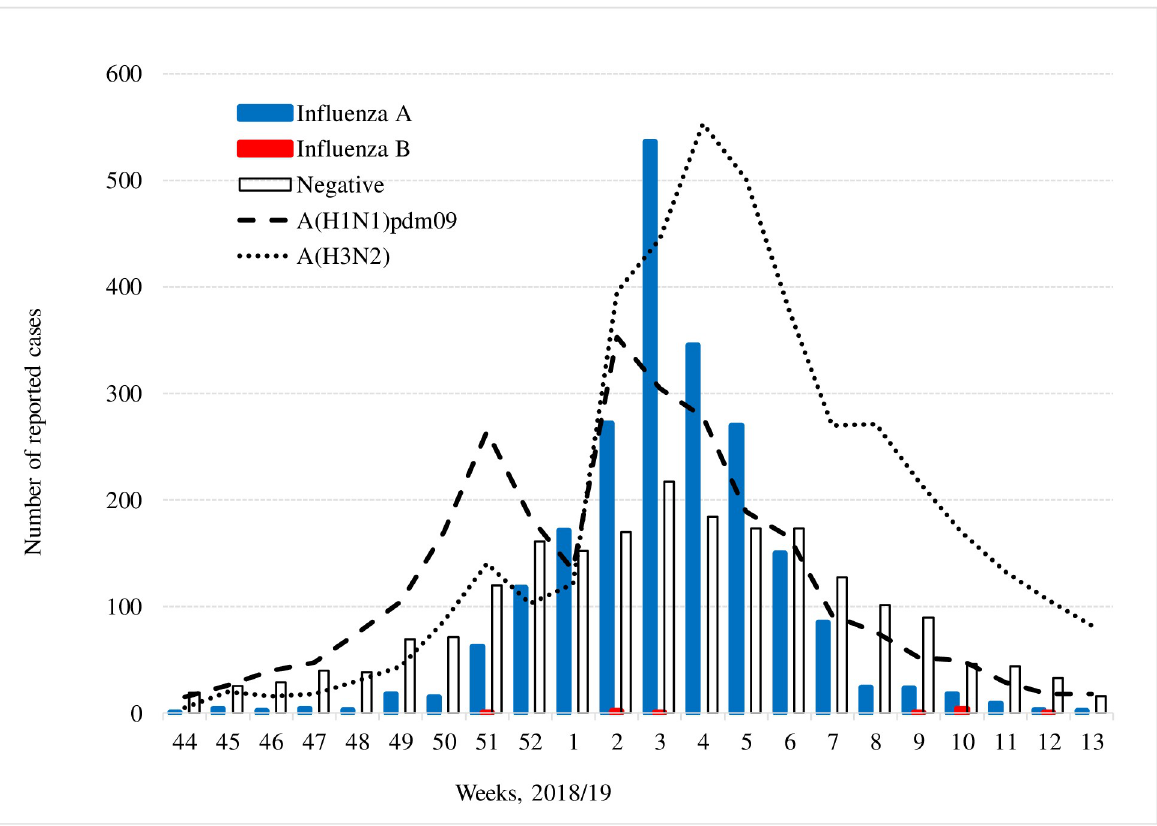
Fig 1. Number of patients tested by rapid influenza diagnostic tests by week in the column chart (n = 4243). Epidemic curves for A(H1N1) pdm09 and A(H3N2) by the World Health Organization in the line graph [16].